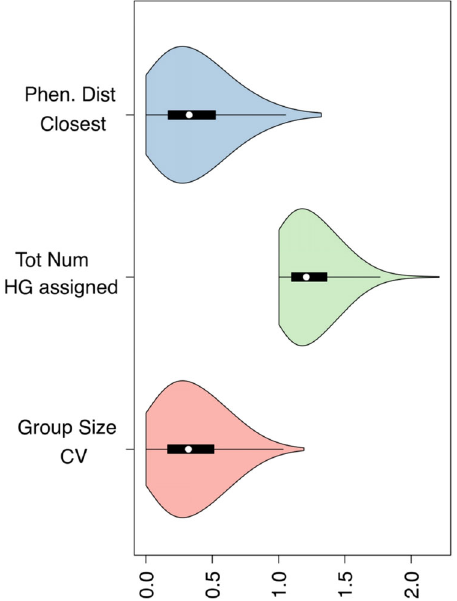
Fig. 3 Stability and reproducibility metrics. Phen. Dist. Closest HG pairs : phenetic distance between closest pairs of HGs formed at distinct bootstrap iterations. This metric measures the similarity between matched HGs formed at different iterations. A value of 0 indicates completely identical HGs (de fi ned by an identical set of genomic variants). Tot. num. HG assignment per genome : distribution of the total number of distinct HGs to which a genomic sequence was assigned at distinct bootstrap iterations. A value of 1 indicates perfect reproducibility (i.e., the genome was consistently assigned to the same HGs at every iteration). HG size CV : coef fi cient of variation (CV) of the size (total number of genomes assigned) to matched HGs formed at distinct bootstrap iterations. A value of 0 indicates no variability in the size of matched HGs (i.e., the same number of genomes is assigned to matched HGs at distinct iterations). Distributions are represented in the form of a violin plot. In the boxplots, white dots denote median values; boxes extend from the 25th to the 75th percentile; vertical extending lines denote adjacent values (i.e., the most extreme values within 1.5 interquartile range of the 25th and 75th percentile of each group). The source data behind this fi gure is reported in Supplementary Data